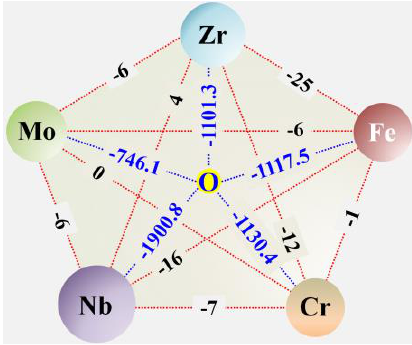
Figure 7. The heats of mixing between the pairs of metal components and the heats for forming different stable metal oxides (unit: KJ/mole) in the Cr-Fe-Nb-Mo-Zr-O system.